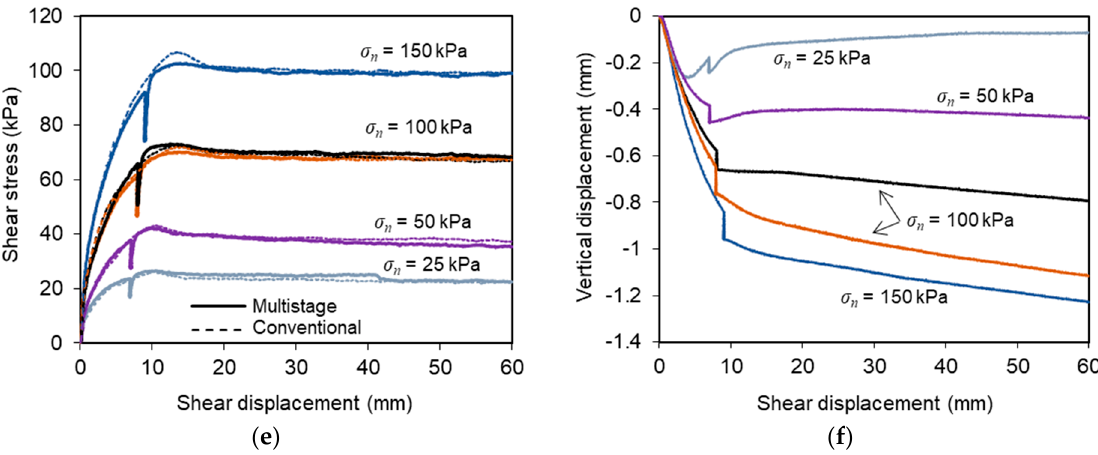
Figure 5. Time-dependent interface response under varying test conditions: ( a , b ) d r /d max = 1/3 and t r = 30 min (tests T-6 to T-10); ( c , d ) d r /d max = 2/3 and t r = 30 min (tests T-11 to T-15); ( e , f ) d r /d max = 2/3 and t r = 120 min (tests T-16 to T-20).